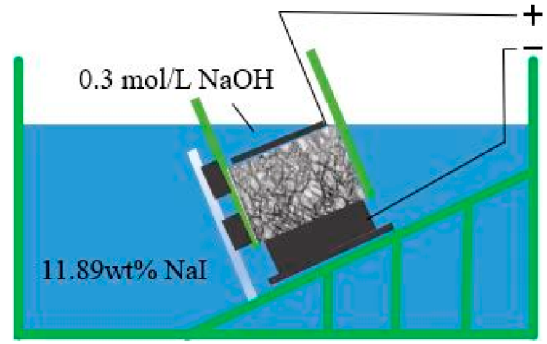
Figure 3. RIM test setup.